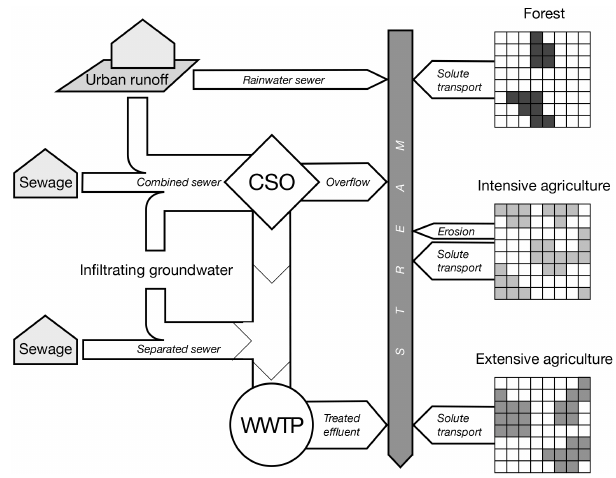
Figure 1. Pollutant sources, flow components, and transport path- ways considered in the iWaQa